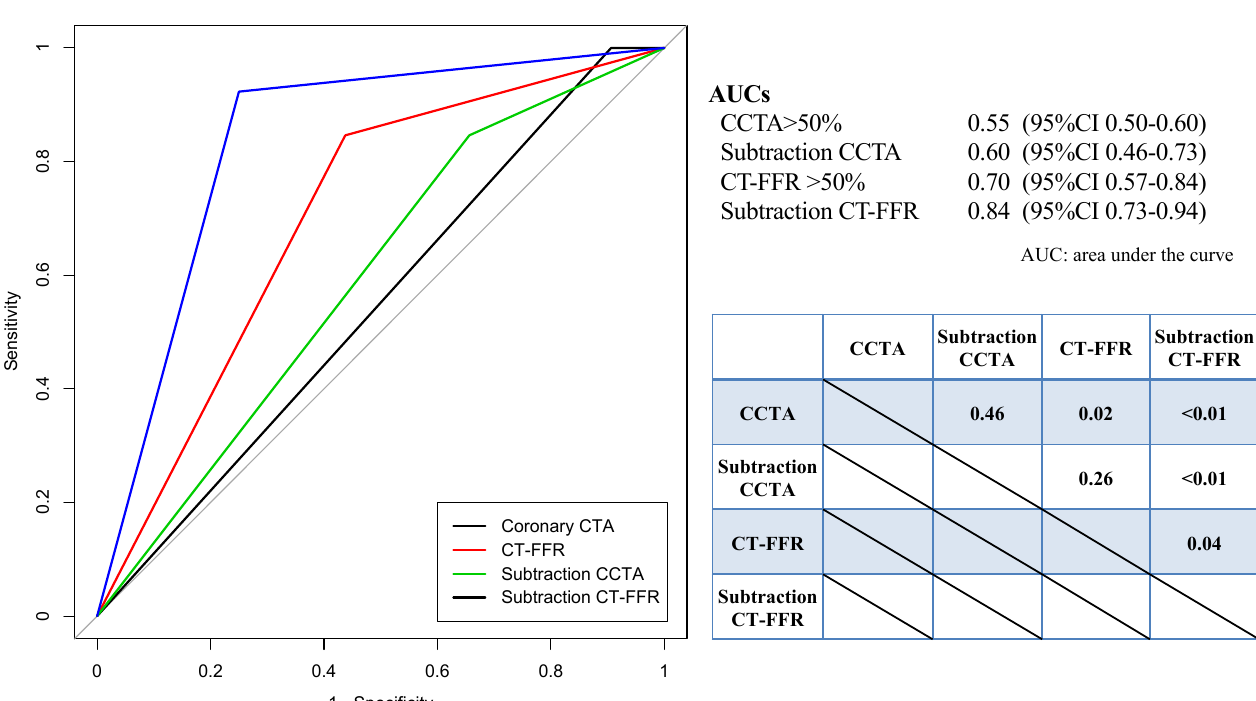
Figure 1. Comparison of areas under the curve (AUC) for the receiver operating characteristic curves of CCTA > 50%, subtraction CCTA > 50%, CT-FFR ≤ 0.8, subtraction CT-FFR ≤ 0.8. A representative case is shown in Figure